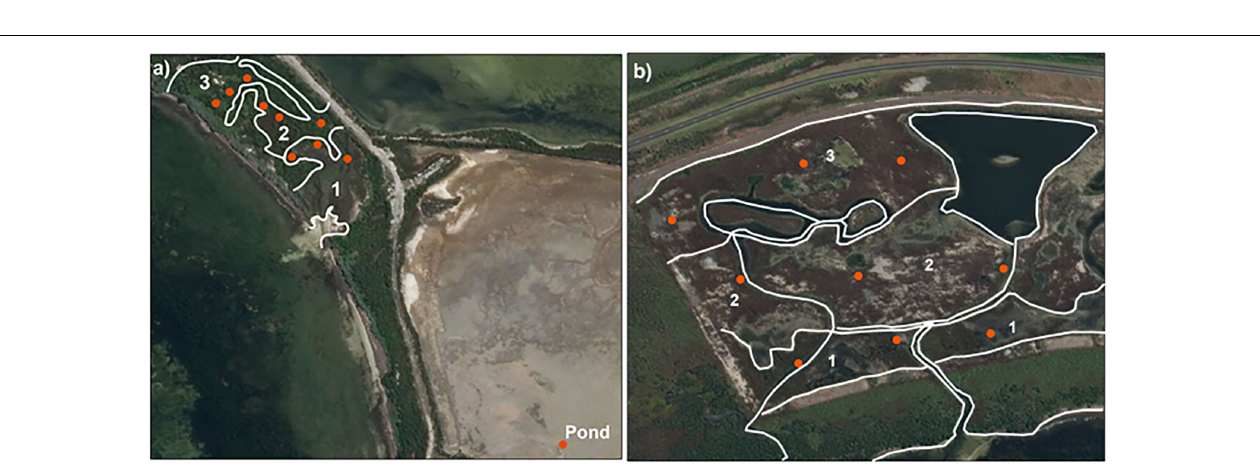
FIGURE 2 | Location of the cores collected from (a) the recovered tidal marsh area and salt pond at Snake Island and (b) the rehabilitated site at the WTP. Given the difference in age of the tidal marsh sites (65 and 7 years old), the saltmarsh species present are different despite inhabiting similar tidal elevations. The recovered saltmarsh site is classified as a wet saltmarsh shrubland tidal marsh community and was split into three categories: (1) Sarcocornia (closest to seaward edge, located adjacent to intertidal seagrass and dominated by Sarcocornia ), (2) Sarcocornia / Tecticornia (located at the transition zone between dominance by Sarcocornia and Tecticornia , which is a large shrub), and (3) Tecticornia (furthest from seaward edge, with little tidal inundation, dominated by Tecticornia) . At the newly rehabilitated site, the locations were similarly split into three zones: (1) Sarcocornia (as above), (2) Sarcocornia/Suaeda (covered equally by Sarcocornia and Suaeda ), and (3) Sarcocornia / Tecticornia/Suaeda an equal mix of the three species and furthest form seaward edge. Triplicate cores were collected from random locations within each of these three categories.